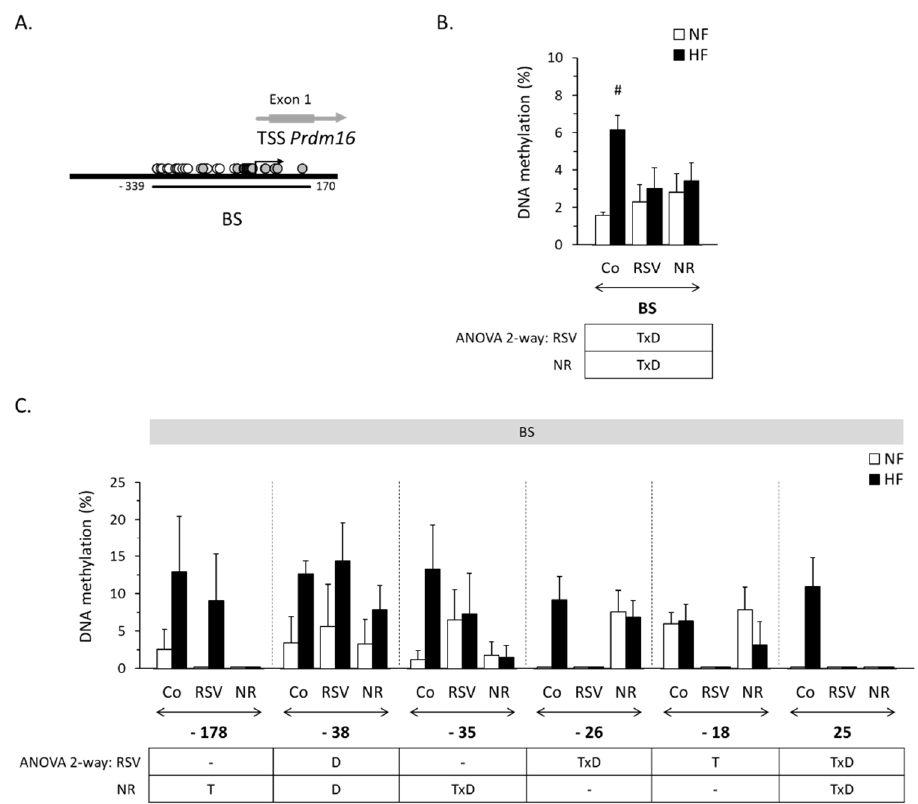
Figure 3. ( A ): Localization of the analyzed bisulfite-sequencing region (BS) surrounding the mouse Prdm16 gene transcription start site (TSS, + 1). Filled circles represent individual CpG sites whose methylation status could be successfully analyzed; empty circles represent CpG sites that could not be analyzed. ( B ): Mean methylation degree in the Prdm16 BS region in inguinal WAT of male mice neonatally treated with resveratrol (RSV) or nicotinamide riboside (NR) and submitted in adulthood to a HF / NF (high-fat / normal-fat) challenge, and corresponding control mice (Co, vehicle-treated). ( C ): Mean methylation degree in all individual CpG sites in the Prdm16 BS region analyzed for which there were significant changes in methylation degree in response to the neonatal treatments, the type of diet or their interaction according to ANOVA 2-way analysis; other individual CpGs in the BS are not represented. Data in B and C: mean ± SEM of 5-6 animals per group. Statistics ( p < 0.05): T treatment, D diet, TxD treatment x diet interaction (ANOVA 2-way); * RSV or NR vs. control, # HF vs. NF ( t -test).